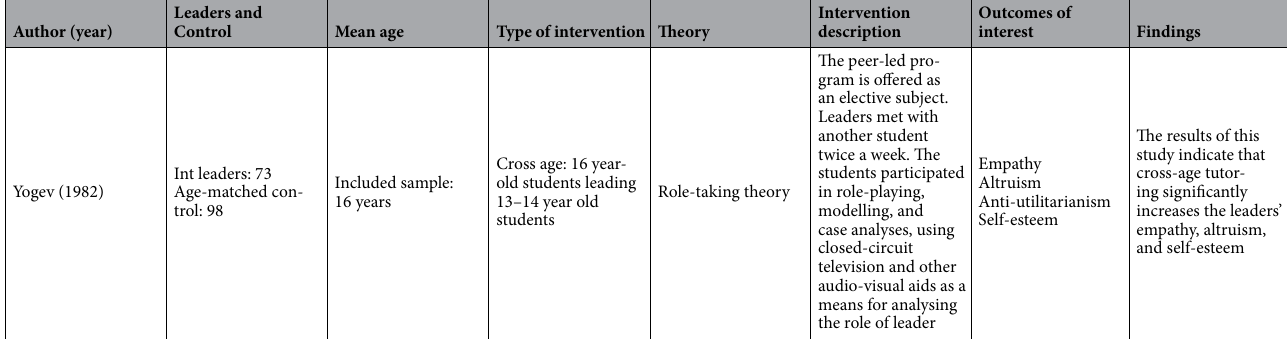
Table 1. Summary of the included studies.